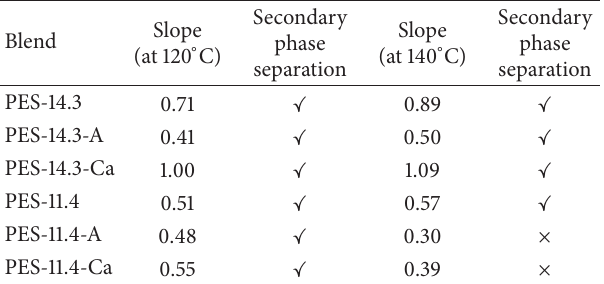
Table 2: Summary of the TRLS experimental results.